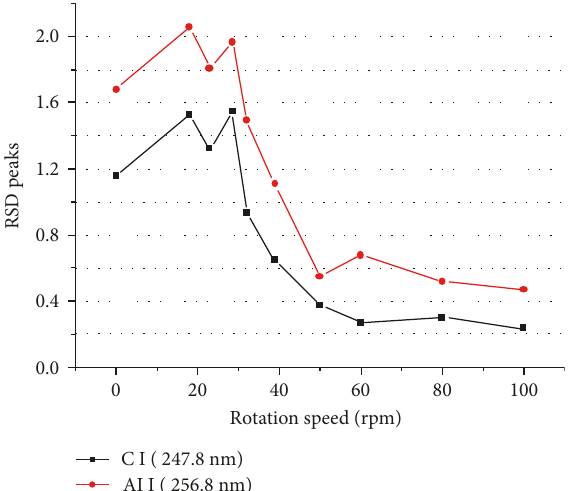
Figure 4: RSD of C I and Al I lines from 20 μ L droplet of peanut oil as a function of the rotation speed; the laser energy is 70